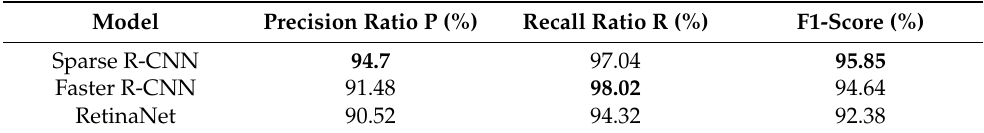
Table 9. Comparison of accuracy of three